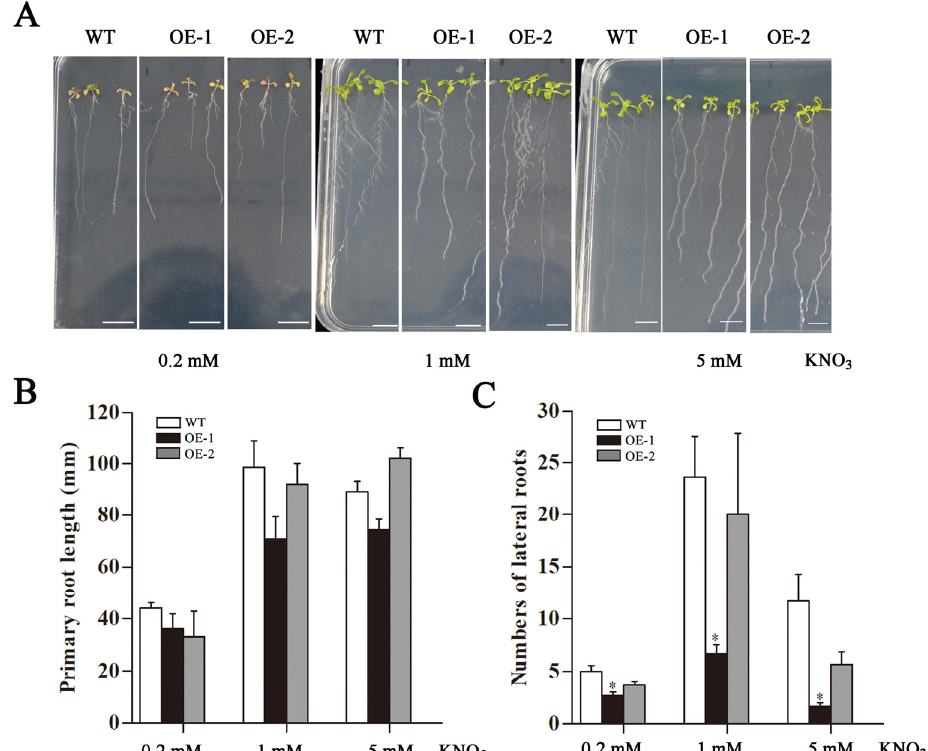
Figure 5. Analysis of roots in WT and transgenic Arabidopsis hosting CsLBD39 gene under KNO 3 treatment. ( A ) The phenotypes of the 15-day-old plants on vertical plates containing different concentrations of KNO 3 . Bar = 1 cm. ( B ) The primary root length ( C ) and numbers of lateral roots of the plants under different KNO 3 conditions. The data are expressed as mean ± standard deviation of three biological replicates ( n = 3). Asterisks (*) indicate that the value is significant difference compared to the WT (* p < 0.05).